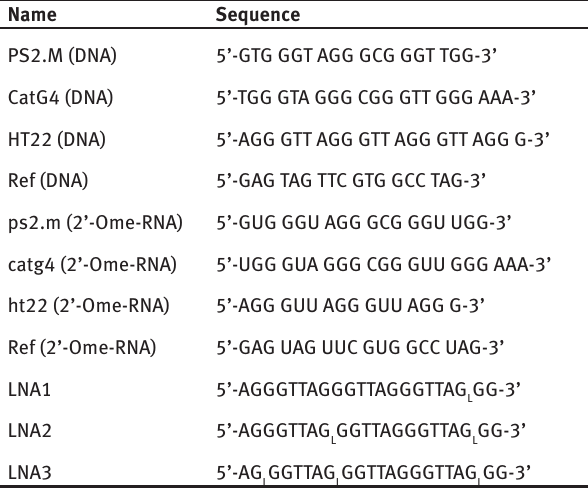
Table 1: Sequences of oligonucleotides used in this study. Name